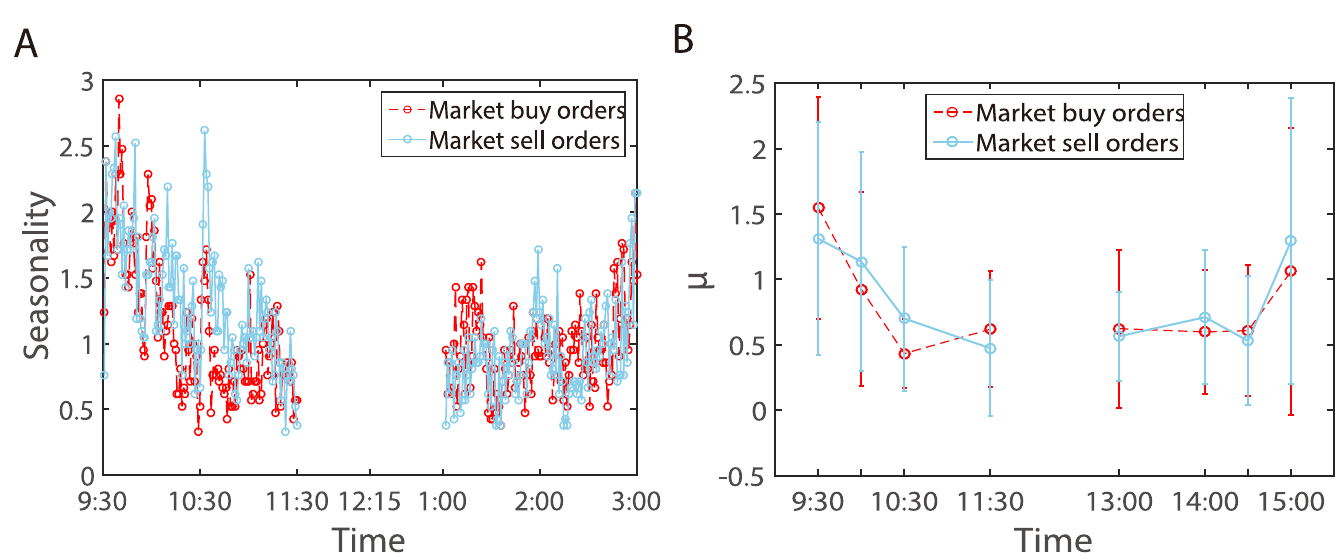
Fig 7. Average number of orders (A) and the estimated intraday baseline intensity splines (events per minute)(B). Error bars are computed for 2 standard deviations.